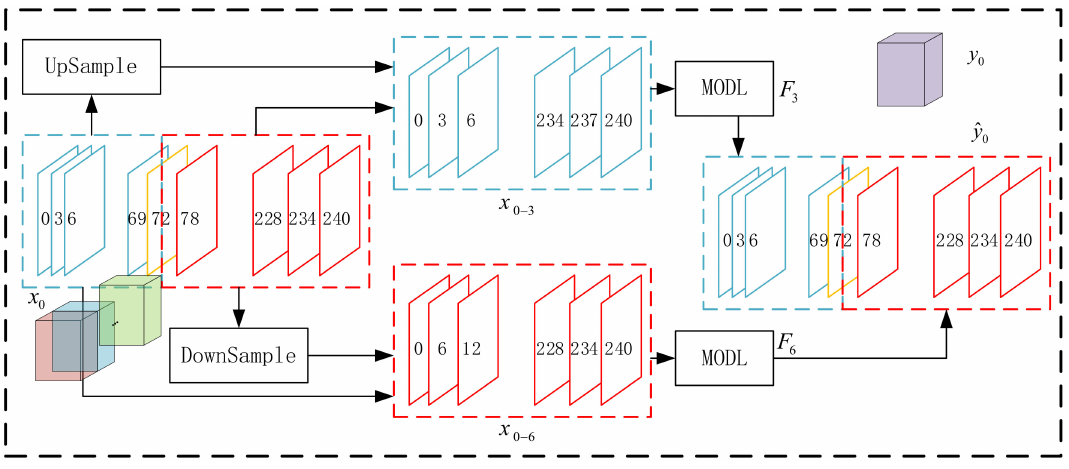
Figure 8. Variable metric in time scale